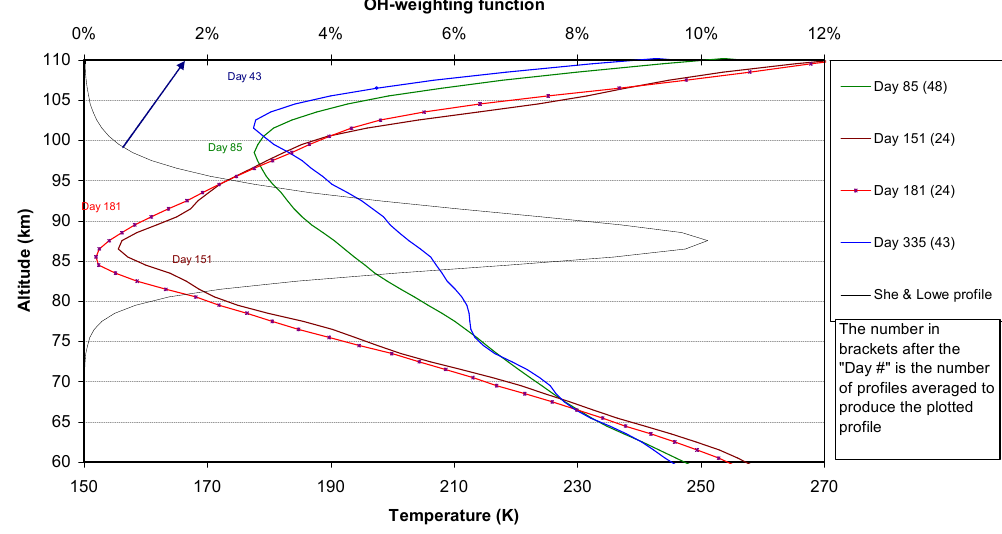
Fig. 7. The average temperature profile for two summer days (day 151 and 181) and two winter days (day 43 and day 85) shown in Fig. 5 are illustrated by reference to the day of the year of each cluster. Also shown is the She and Lowe (1998) weighting function for illustrative purposes. The lower x-axis applies to the temperature profiles, while the upper x-axis refers to the weighting